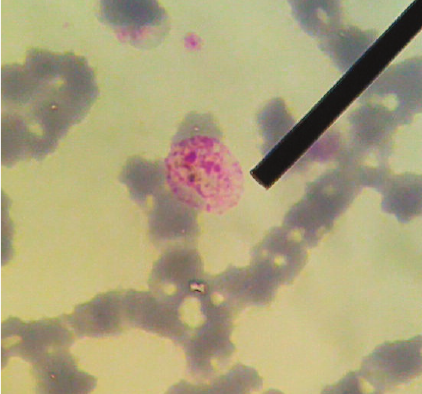
Figure 1: Peripheral blood smear of case 1 showed gametocyte form of Plasmodium vivax.